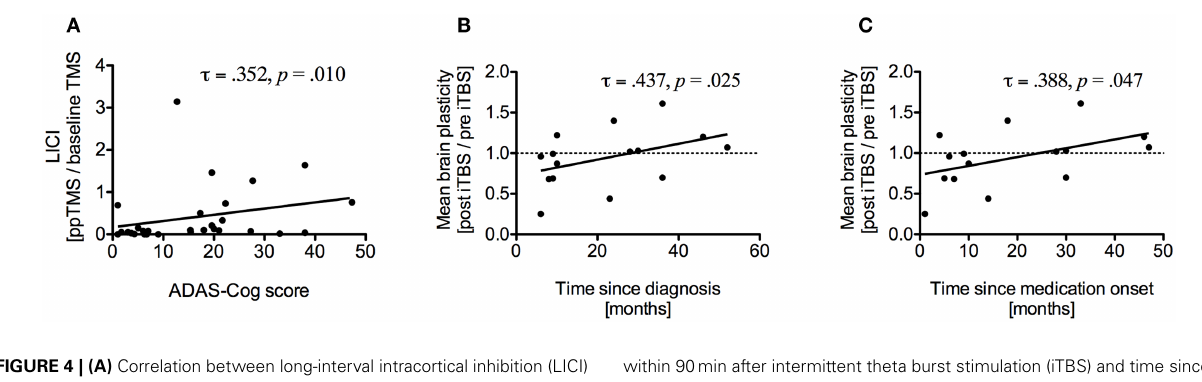
FIGURE 4 | (A) Correlation between long-interval intracortical inhibition (LICI) and ADAS-Cog scores of all study participants. Higher ADAS-Cog scores indicate more dysfunction. (B) Correlation between average brain plasticity